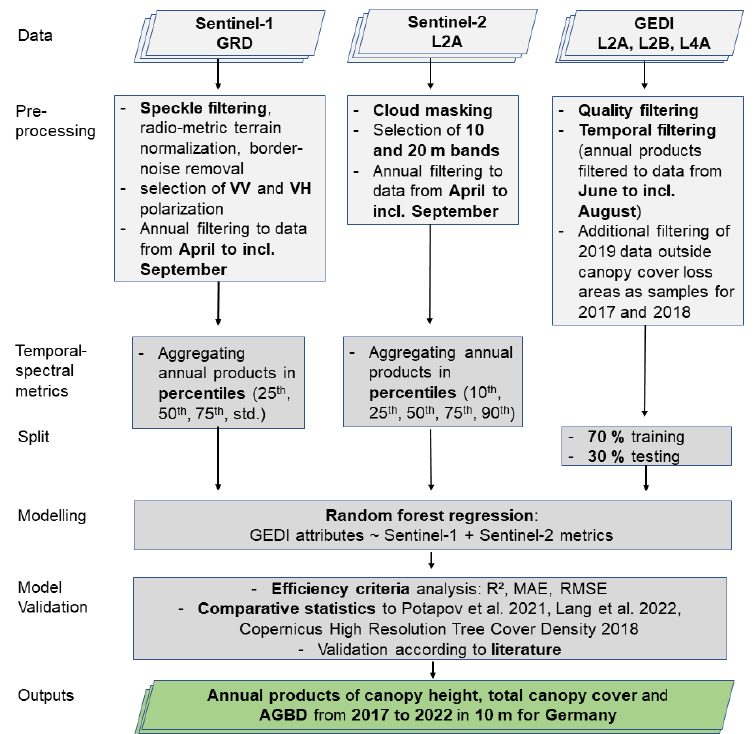
Figure 4. Workflow chart of the processing steps of Sentinel-1, Sentinel-2 and GEDI data in order to derive annual wall-to-wall products (10 m) of canopy height, total canopy cover and AGBD from 2017 to 2022 for Germany. The workflow builds up on Kacic et al., 2021 [50] and extends the methodology towards multi-temporal modeling including GEDI L4A data. Comparative statistics are based on Potapov et al. 2021 [36] and Lang et al. 2022